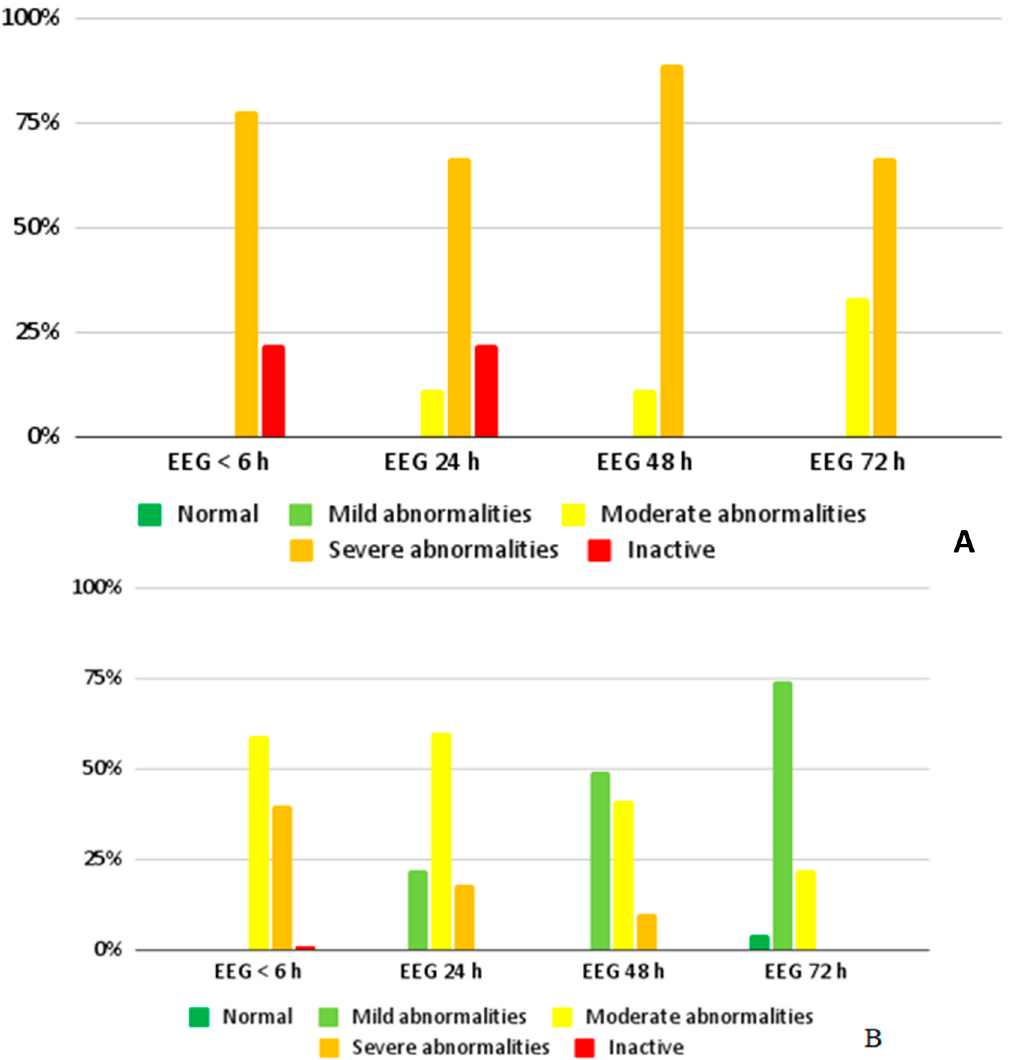
Figure 6. p-EEG variation in patients with severe ( A ) and normal or moderately abnormal neurdevelopmental outcomes ( B ).